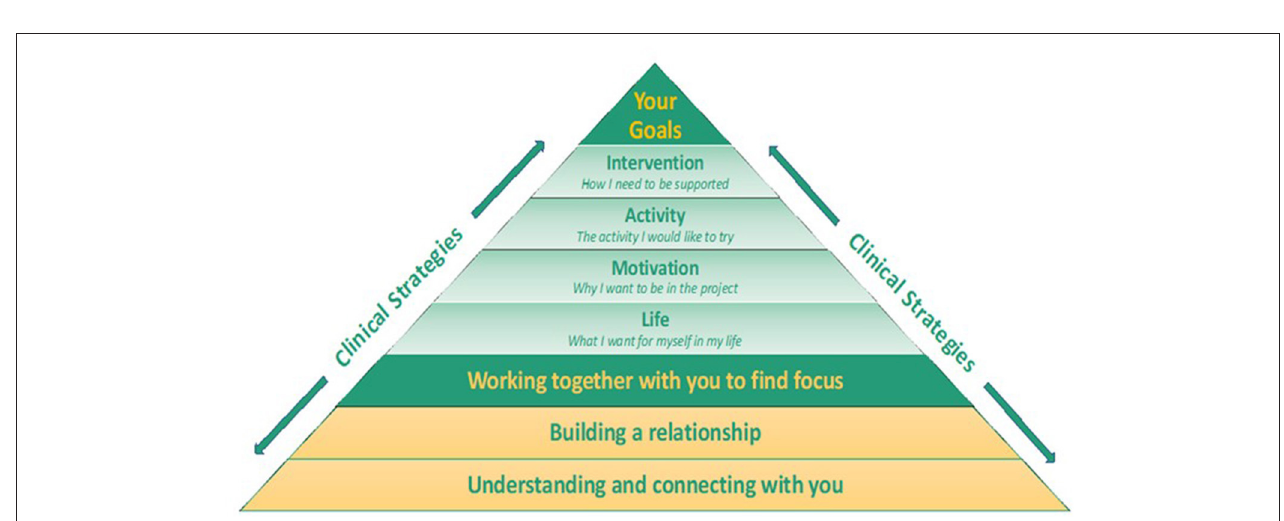
FIGURE 2 | Finding focus within a multi-level goal